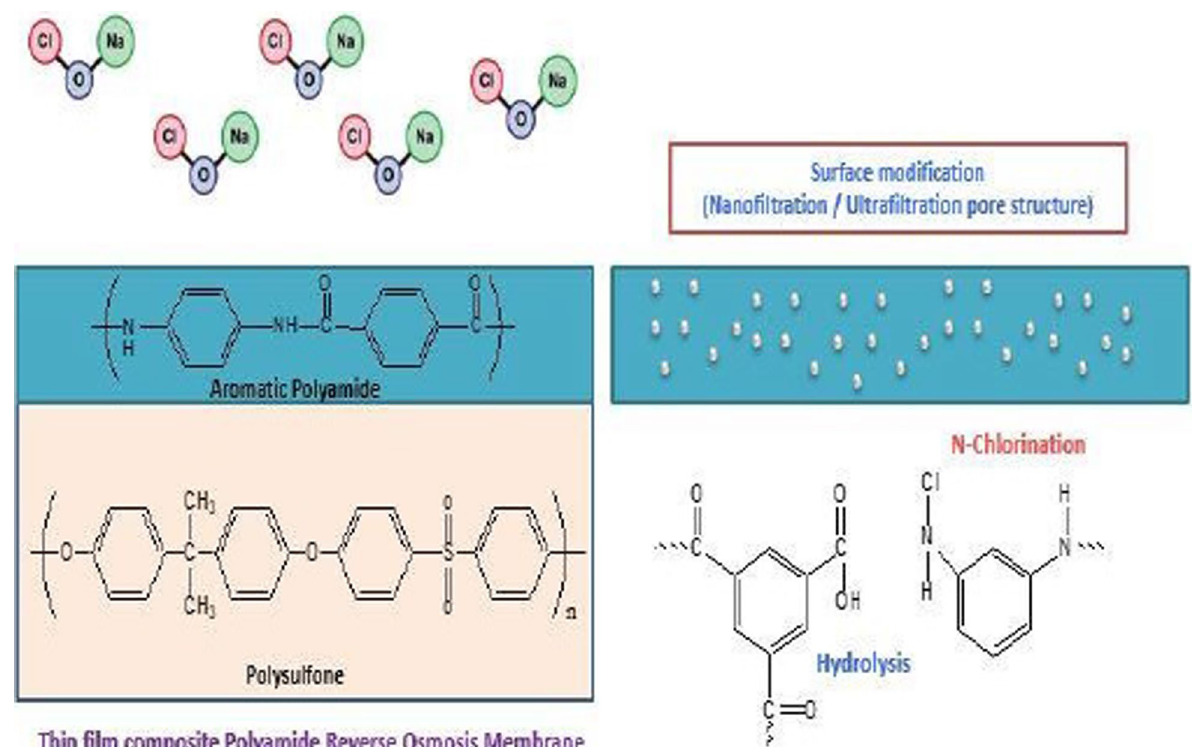
Fig. 2 Schematic representation of chemical transformation of RO to NF membrane